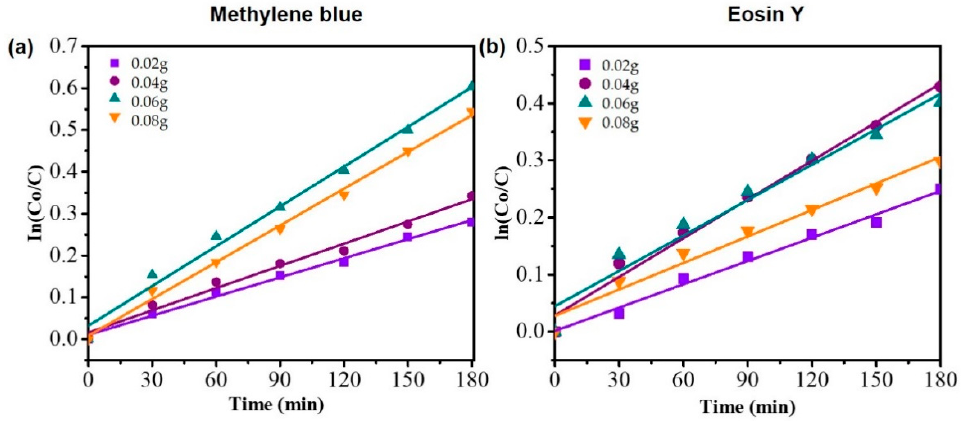
Figure 7. Kinetic study of MB ( a ) and EY dye ( b ).